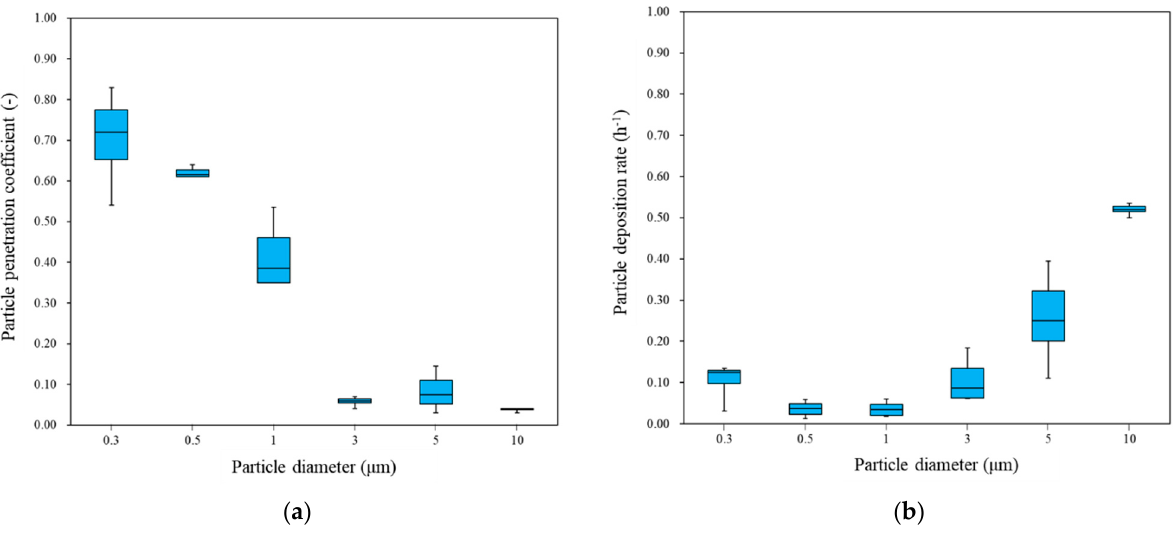
Figure 4. ( a ) Penetration coefficients and ( b ) deposition rates of size-resolved particles.